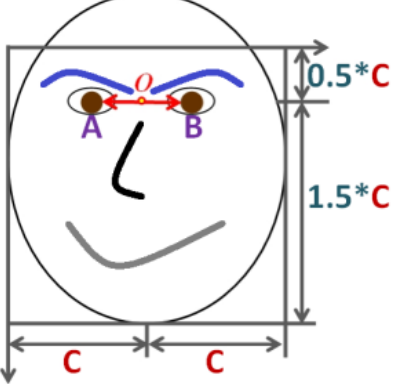
Figure 12. Image clipping ratio diagram.